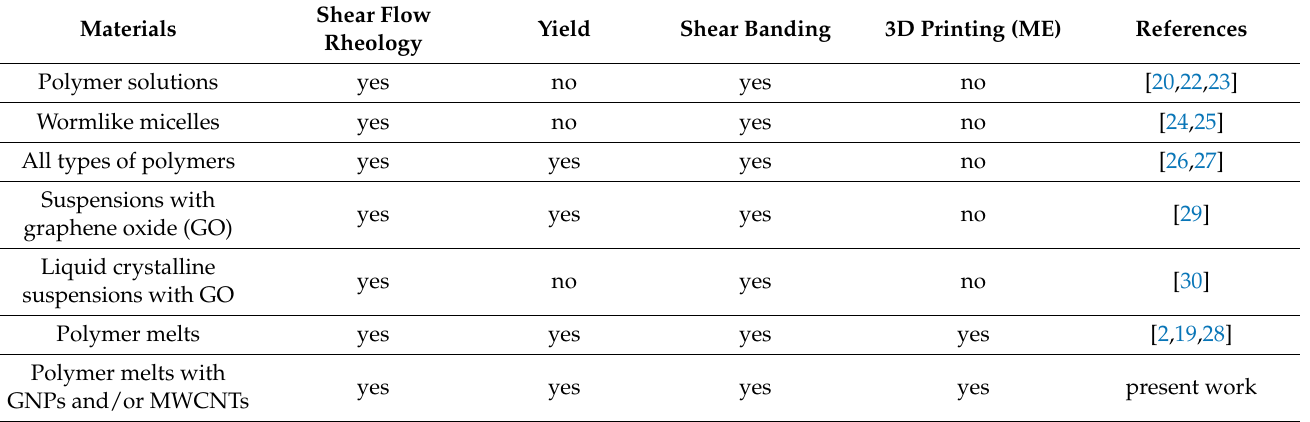
Table 4. Comparison of related